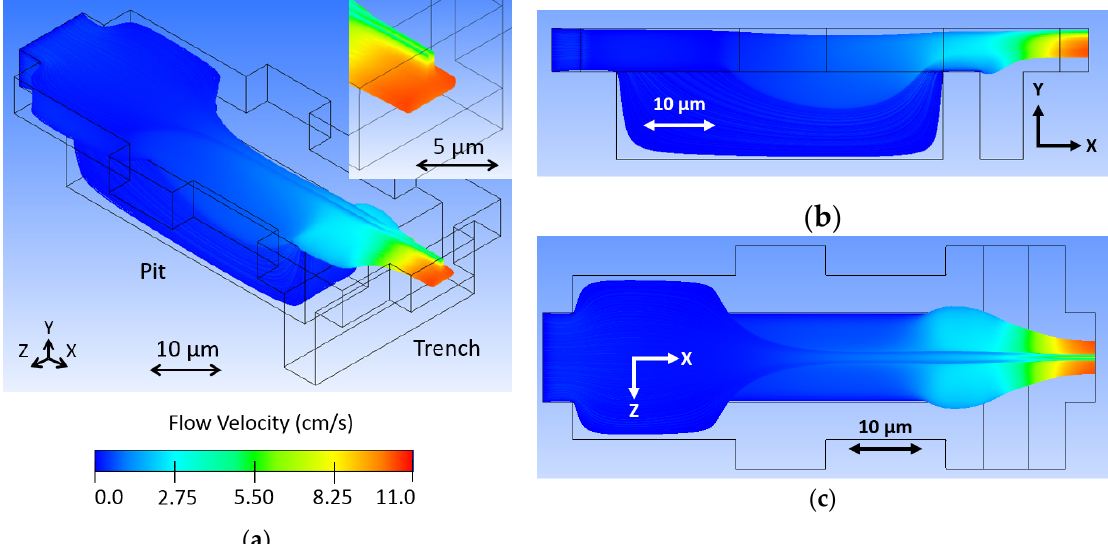
Figure 4. Sample fluid flows in the X direction of the fluid junction model in an ( a ) oblique view, ( b ) side view, and ( c ) top view, where buffer fluid is transparent and sample fluid is colored from dark blue to red, representing the range of flow velocities from slow to fast. A uniformly distributed particle concentration at the sample inlet becomes a focused particle distribution at the outlet.